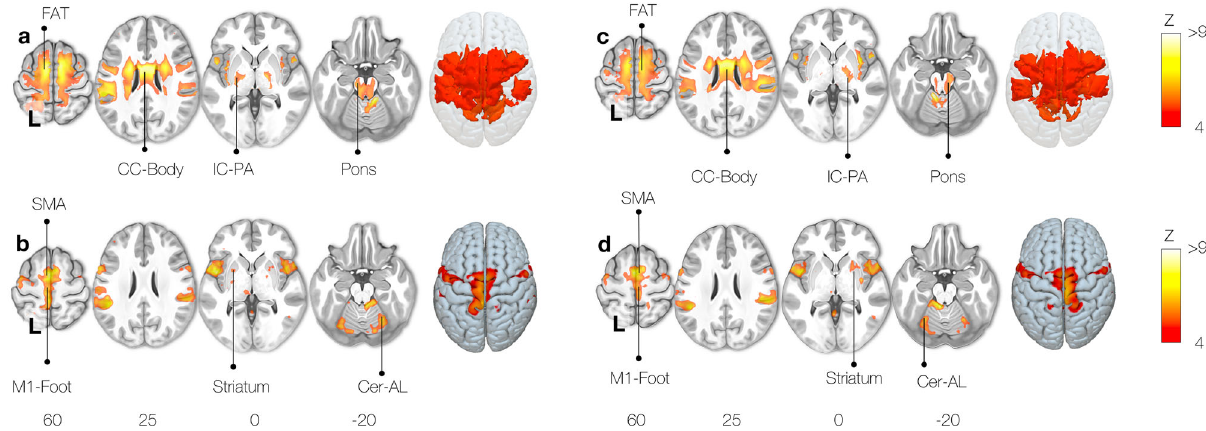
Fig. 4 Motor task activation network for toe clenching. Right foot ( a : functionnectome, b : classic) and left foot ( c : functionnectome, d : classic) toe clenching activation maps. FAT: Frontal Aslant Tract, CC-Body: Corpus Callosum body, M1: Primary motor cortex, SMA: Supplementary motor area, Cer- AL: Cerebellar anterior lobe, IC-PA: Internal capsule